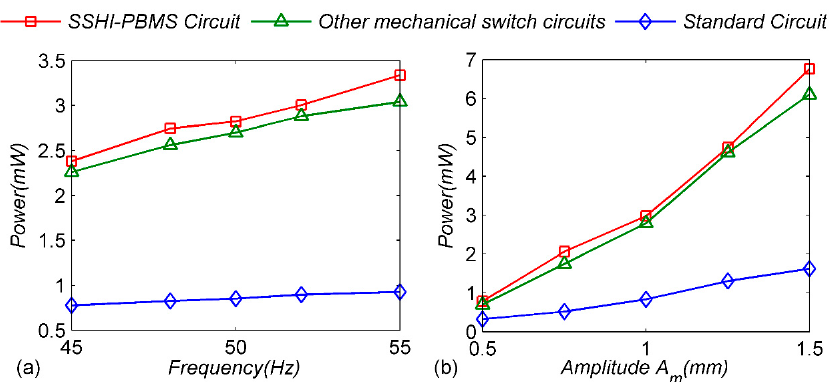
Figure 10. Experimental maximum-harvested-power comparison between SSHI-PBMS circuit and standard circuit for varied displacement frequencies or amplitudes: ( a ) constant amplitude 1 mm; ( b ) constant frequency 50 Hz.